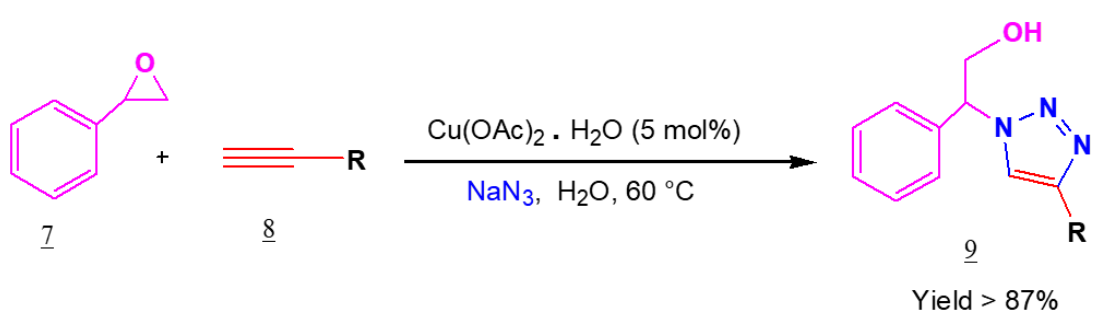
Figure 7. One-pot synthesis of β -hydroxy-1,2,3-triazole derivatives from epoxides catalyzed by Cu(OAc) 2 H 2 O in water.